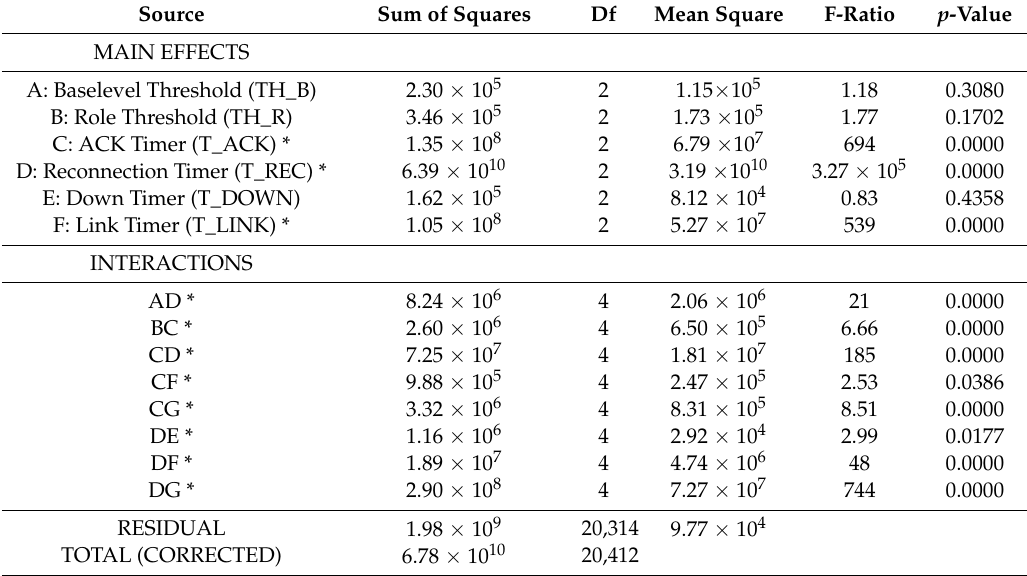
Table 6. Summary of the ANOVA table, which decomposes the variability Set-Up Energy (mWs) into contributions due to several factors. The factors and interactions marked with * are statistically significant.